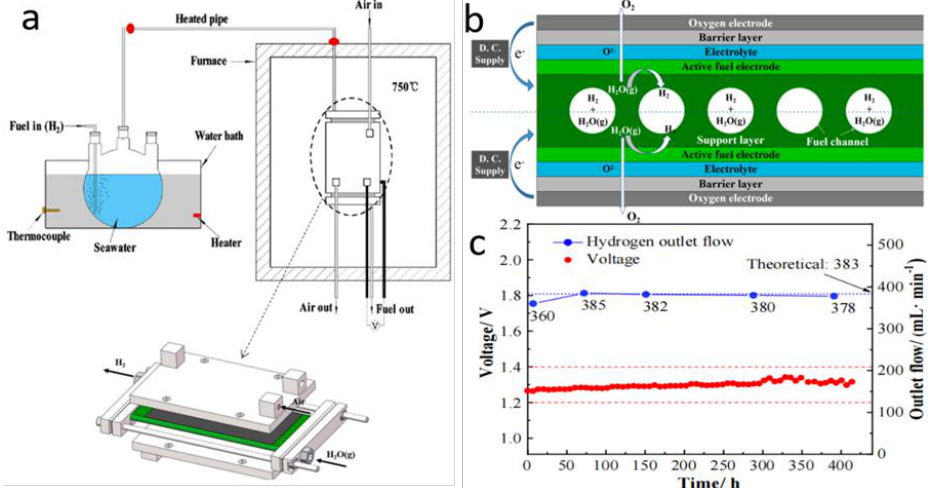
Figure 10. Schematic diagrams of ( a ) SOEC device and ( b ) water electrolysis process in an SOEC. ( c ) Chronopotentiometry curve of LSCF (La 0.6 Sr 0.4 Co 0.2 Fe 0.8 O 3 ) in natural seawater electrolytes [91]. Adapted with permission from Ref. [91], Copyright 2021, Elsevier.